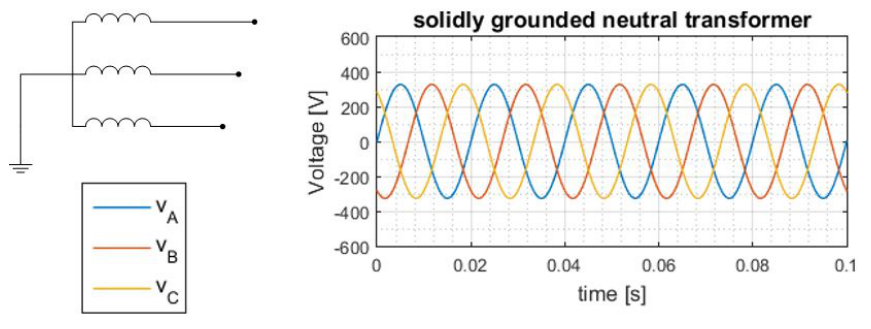
Figure 9. Current at AC nanogrid’s central node during fault for different neutral transformer grounding. According to Figure 10b, the voltage of the healthy phases might reach line-to-line value. This is because when the neutral transformer is grounded with a resistance, once a fault occurs, the voltage at the neutral point is no longer 0 V. This voltage increases according to the resistance and impedance along the faulted line to the neutral point. In addition, the phase to neutral voltage of the healthy phases ( v Bn and v Cn , assuming the fault is from phase A to ground) is